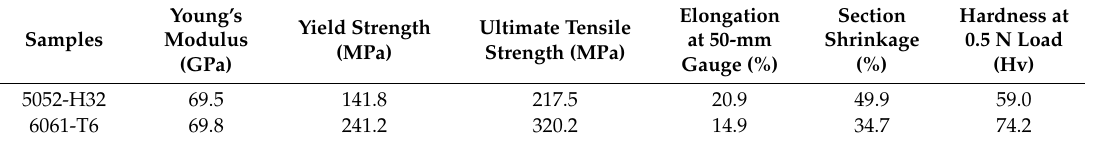
Table 2. Mechanical properties of two automotive aluminum